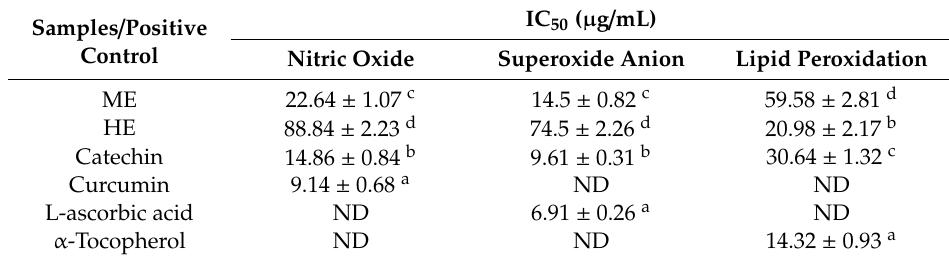
Table 1. The 50% inhibition concentration (IC 50 ) of nitric oxide, superoxide anion scavenging activities, and the inhibitory e ff ect on lipid peroxidation.